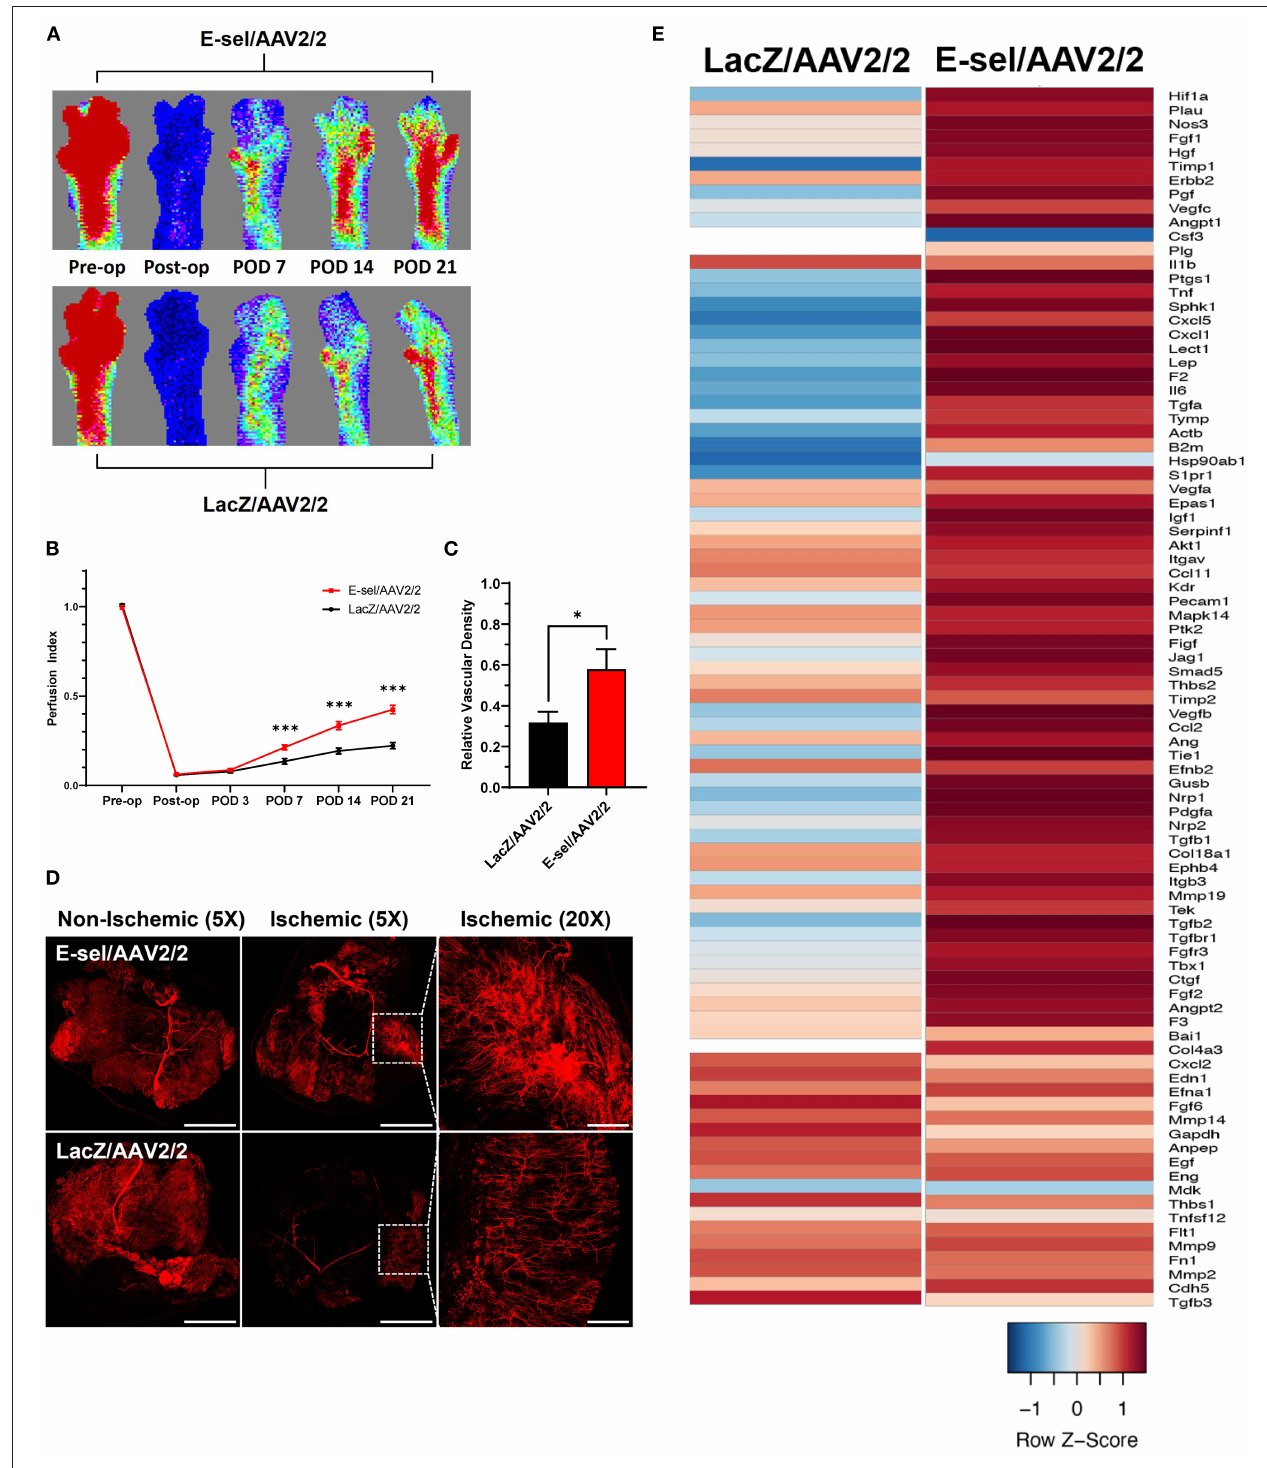
FIGURE 2 | Hindlimb reperfusion and angiogenesis gene profile is enhanced by E-sel/AAV2/2. (A) Representative laser Doppler perfusion images and (B) quantification of perfusion indices demonstrating improved recovery of footpad perfusion in mice treated with E-selectin/AAV2/ compared to LacZ/AAV2/2. (C) Quantification and (D) representative confocal microscopy images of calf muscle following whole-body perfusion with DiI to stain the peripheral vasculature on POD 22. Scale bars represent 5 and 1mm for 5X and 20X images, respectively. (E) PCR array demonstrating upregulation of several angiogenesis genes in muscle treated with E-sel/AAV2/2 compared to LacZ/AAV2/2 control vector. Data are presented as mean ± SEM where * P < 0.05 and *** P < 0.001.